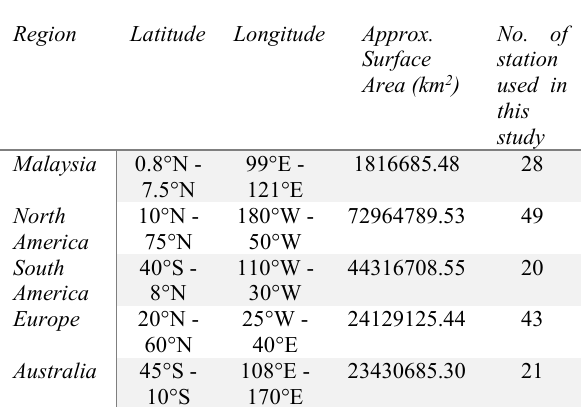
Table 2. Boundary and numbers of stations used in the region